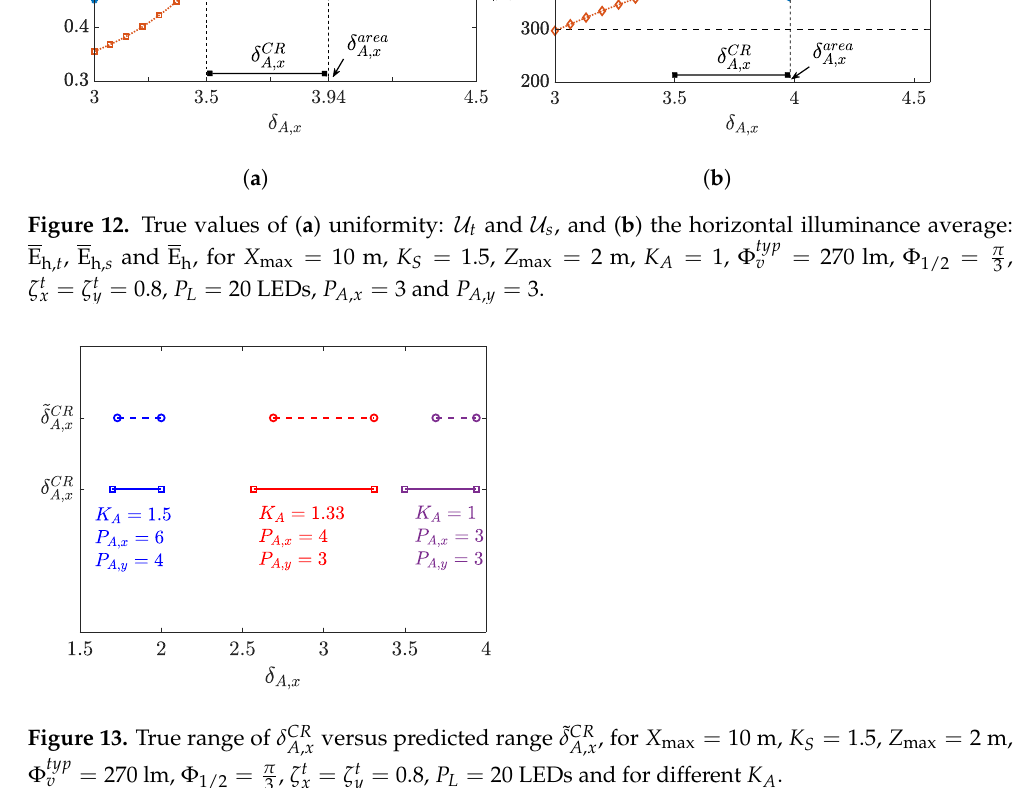
, for X max = 10 m, K S = 1.5, Z max = 2 m, A , x